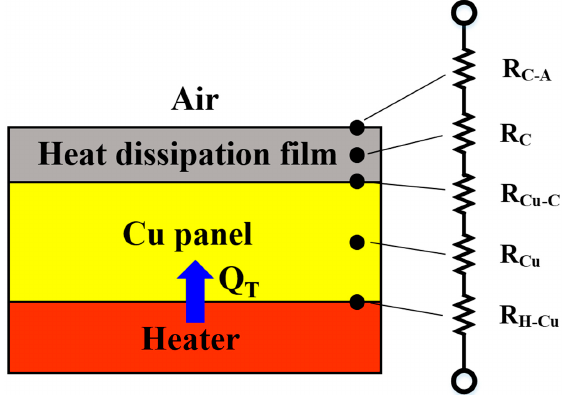
Figure 1. Schematic of the R total from the heater to the outside ambience through the bare copper panel and heat dissipation film .